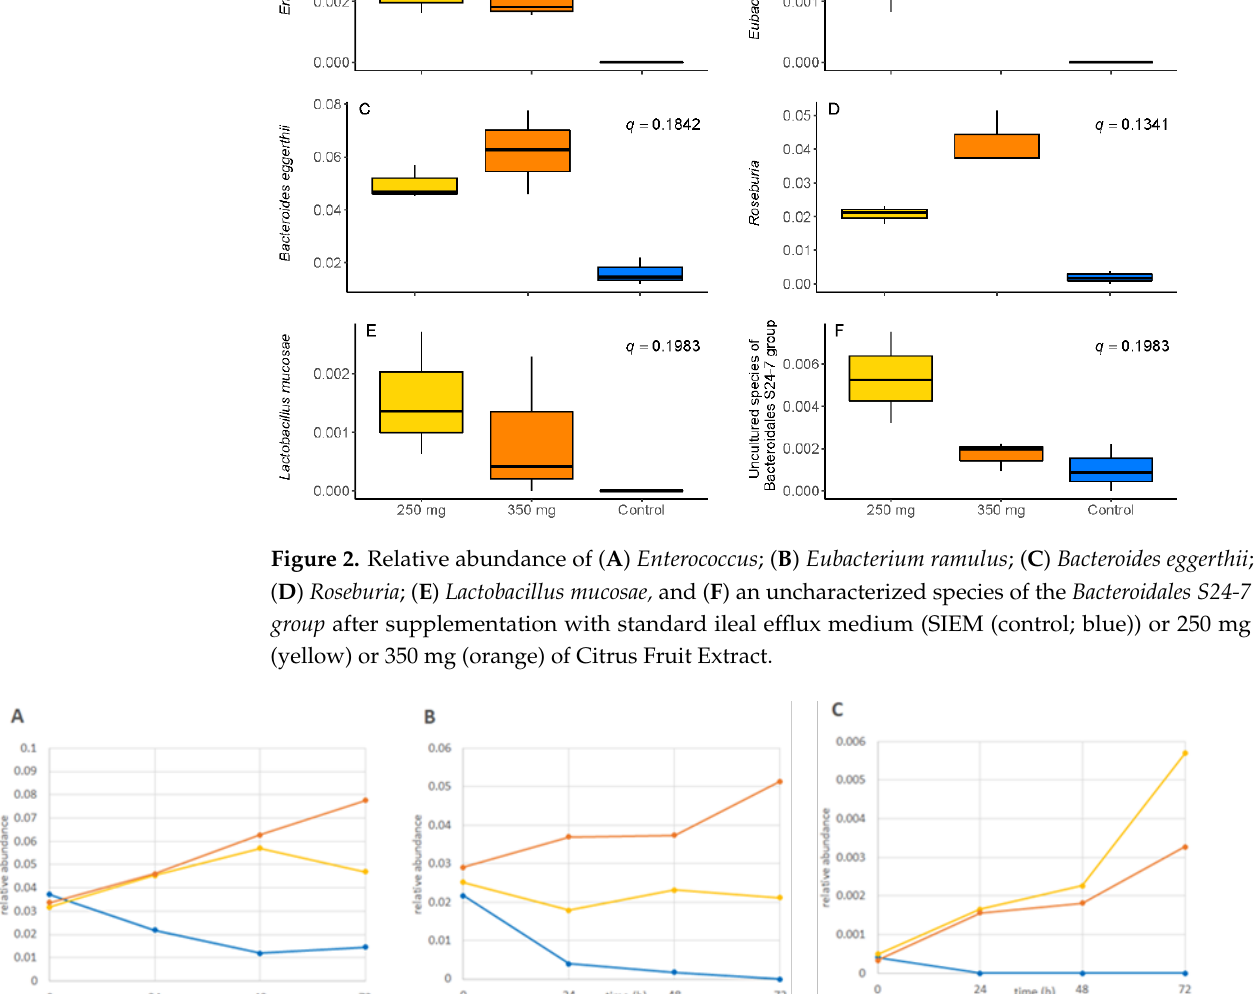
Figure 3. Changes in the relative abundance overtime of ( A ) B. eggerthii; ( B ) Roseburia, and ( C ) Enterococcus for the interventions with 250 mg (yellow) and 350 mg (orange) Citrus Fruit Extract and the control (standard ileal efflux medium (SIEM; blue)). Similar graphs for the other 3 taxa can be found in Figure S3.